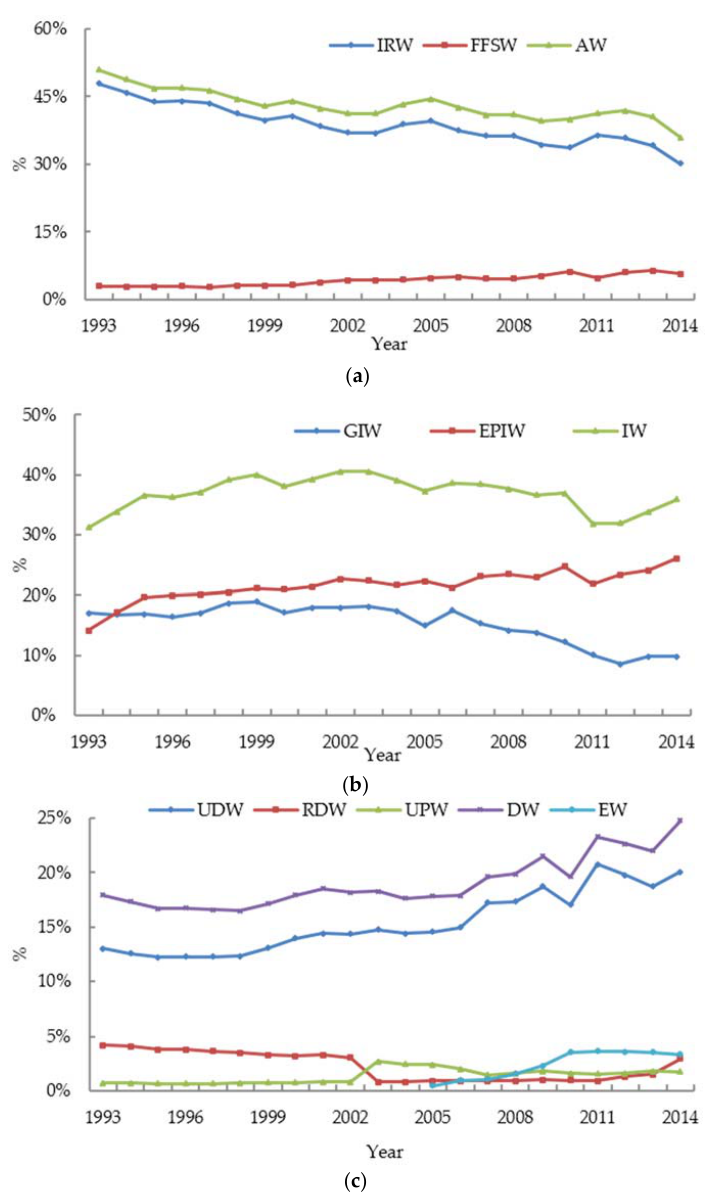
Figure 4. Changes in relative proportions of water consumption by different sectors in Nanjing from 1993 to 2014. ( a ) Changes in relative proportions of water consumption by different agricultural sectors; ( b ) Changes in relative proportions of water consumption by different industrial sectors; ( c ) Changes in relative proportions of domestic water and ecological water consumption.